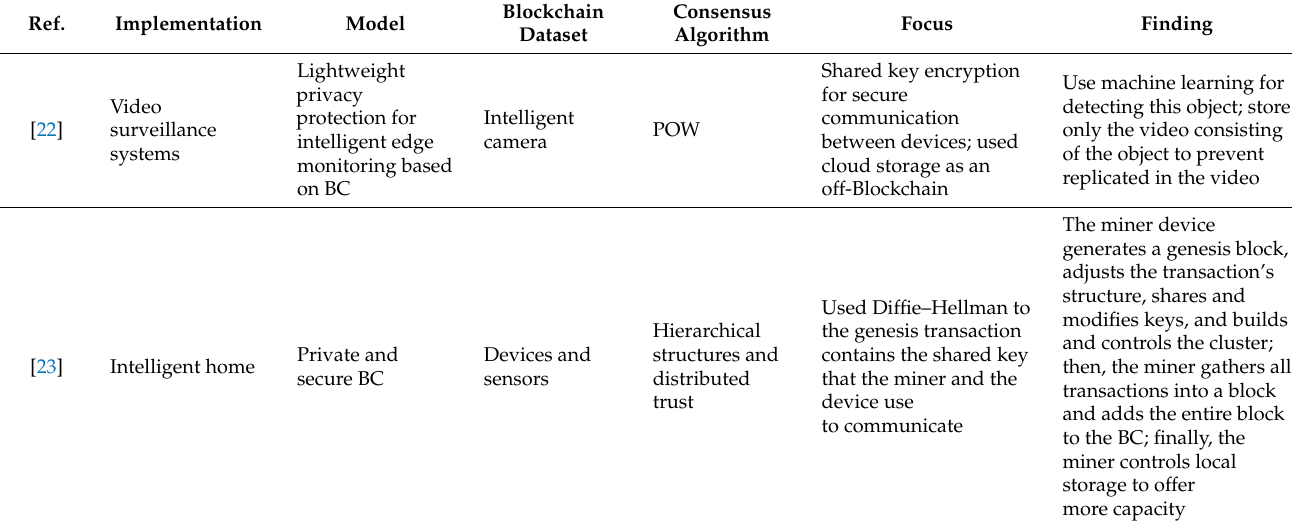
Table 1. Findings of previous